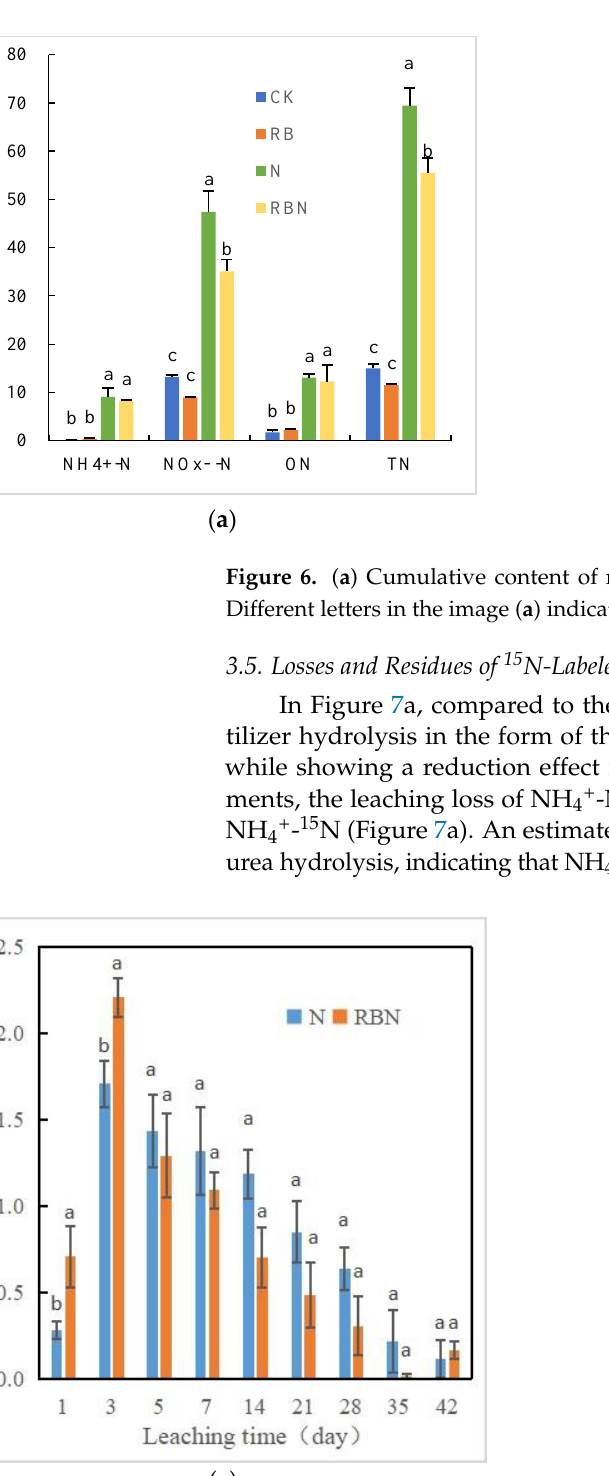
Figure 7. ( a ) Loss of NH 4+ - 15 N; ( b ) loss of NO x- - 15 N. Different letters in the image indicate signifi- cant differences between treatments (p < 0.05).